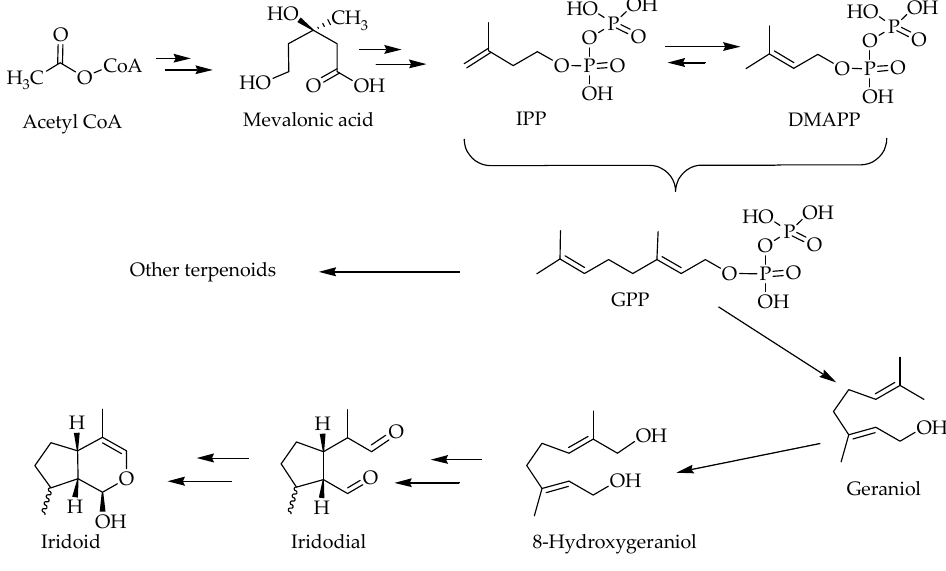
Figure 2. An overview of biosynthesis pathway of iridoids.